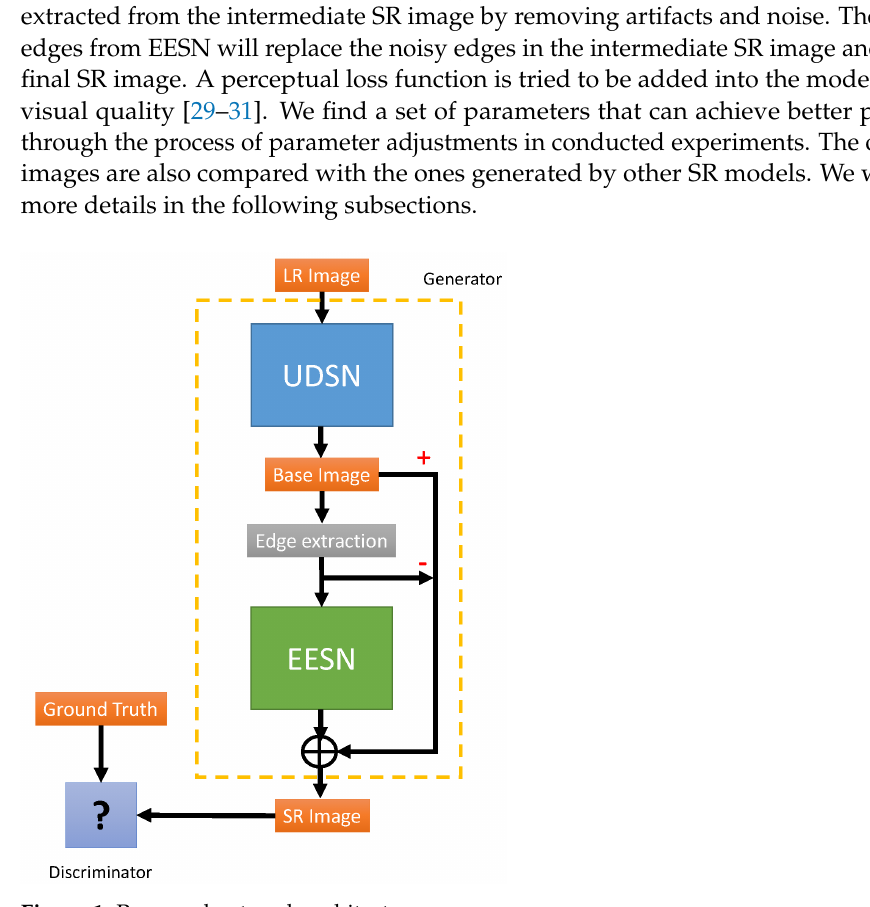
Figure 1. Proposed network